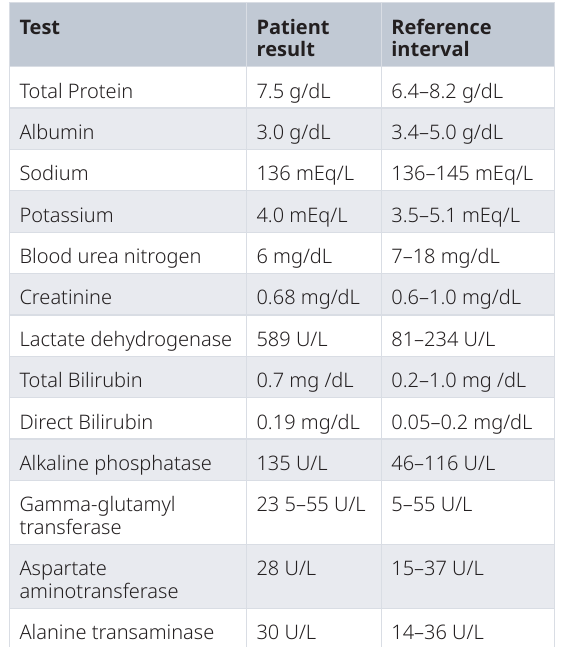
Table 2. Biochemistry and liver function tests.